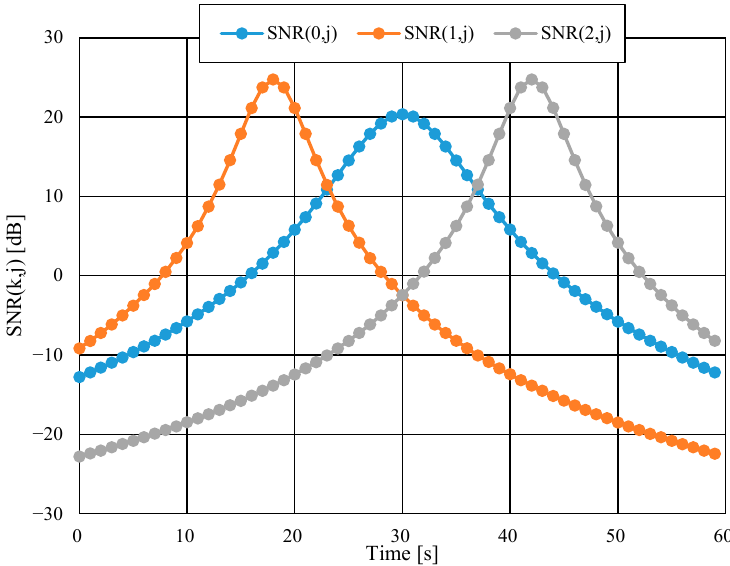
Figure 8. Average uplink SNR of each base station.